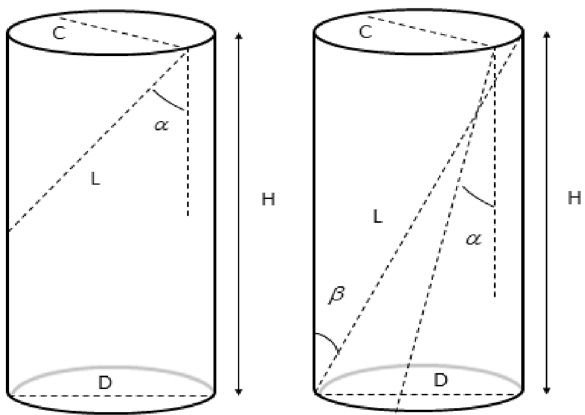
Fig. 2 Sketch graphs of fracture parameters